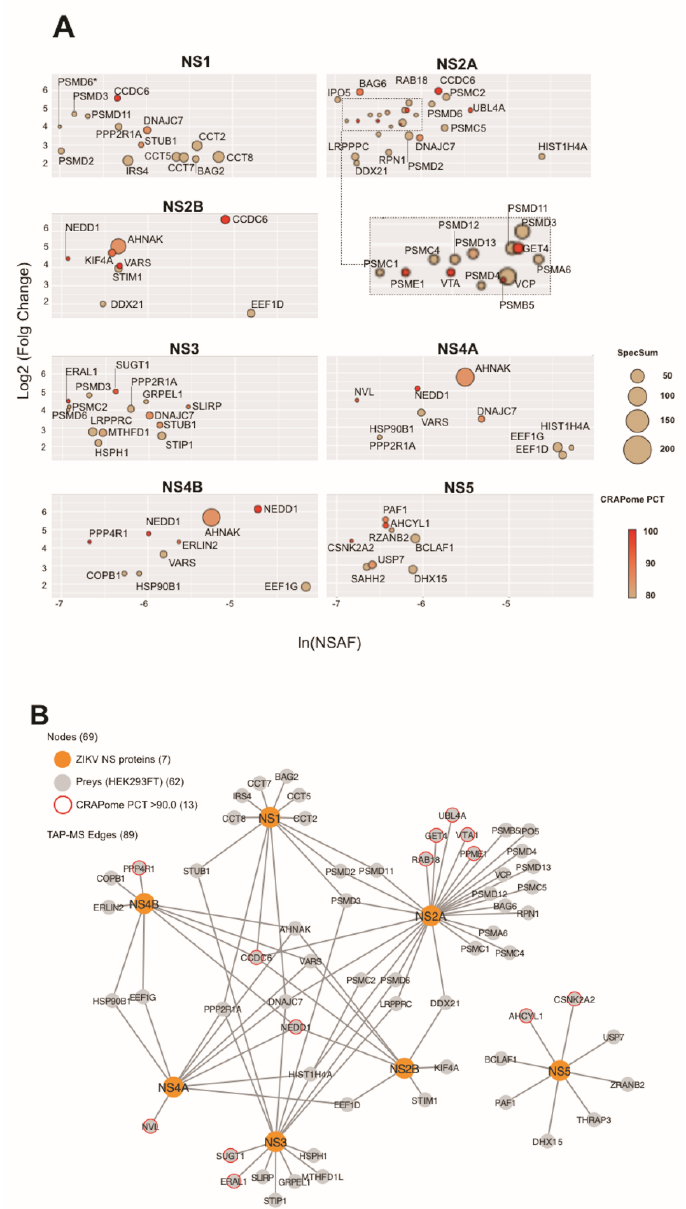
Figure 2. TAP-MS PIN . ( A ) Protein interaction profile of TAP-MS screenings plotted based on spectral abundance factor (NSAF) [34] (X axis) and specificity based on fold change of spectral counts (Y axis) between TAP-tagged NS proteins and TAP-tagged GFP (negative control). Node size denotes the spectral sum (Spec sum) obtained for each protein. Node color denotes CRAPome PCT score according to the scale. ( B ) Network of the interactions identified by TAP-MS screens. Orange nodes represent ZIKV NS proteins (baits) and gray nodes represent human proteins (preys). Gray nodes with a red circle indicate a prey with high CRAPome